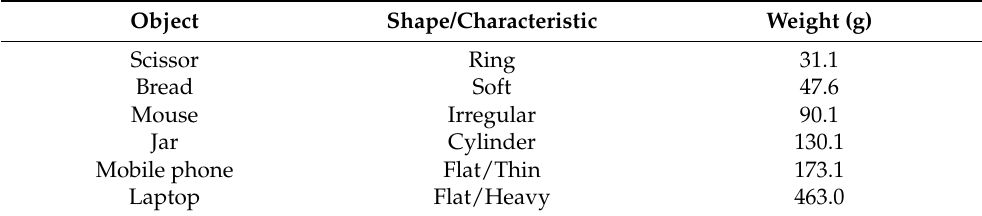
Table 2. Object shapes and